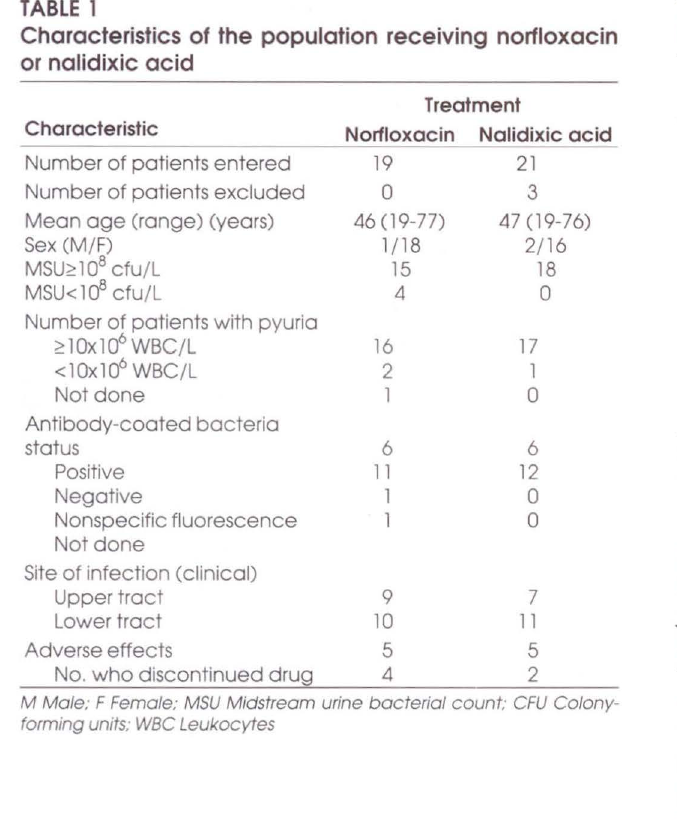
Characteristics of the population receiving norfloxacin Infecting organisms with antimicrobial susceptibility